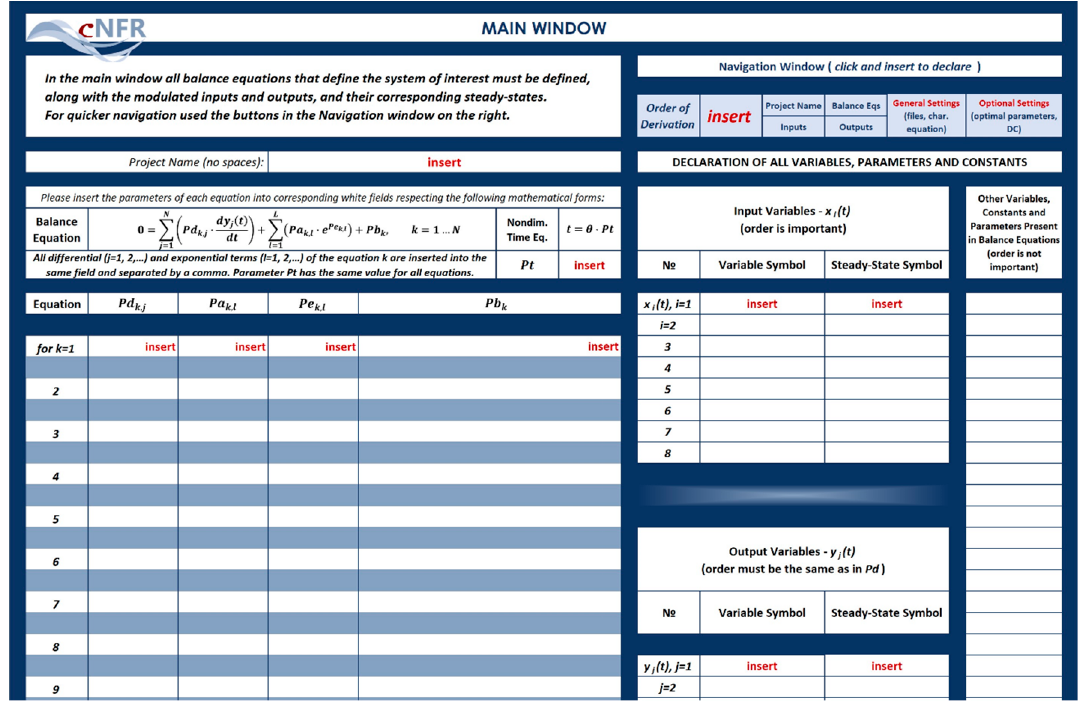
Figure 4. The cNFR Main Window.